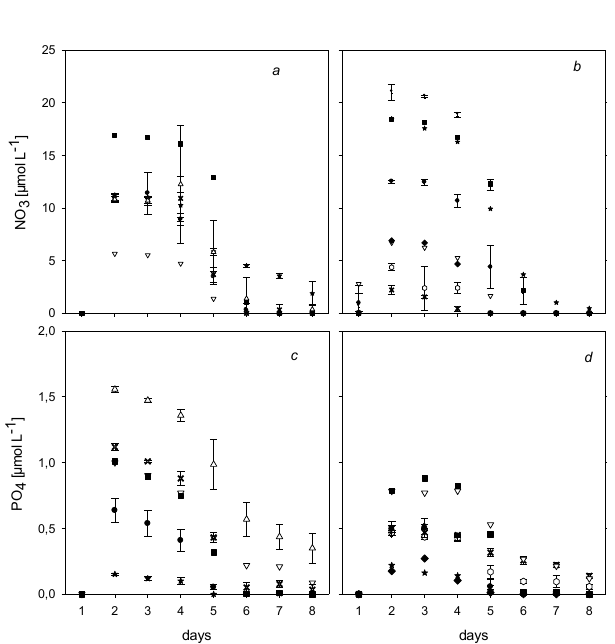
Figure 2. Nutrient concentrations during two series of mesocosm experiments with varied supply of PO 3 − ( Varied P; a , c ; n = 16) 4 or NO − ( Varied N ; b , d ; n = 16), respectively. For treatments with 3 identical nutrient supply, average values are given ± 1 standard de- viation (error bars). See Table 1 for explanation of